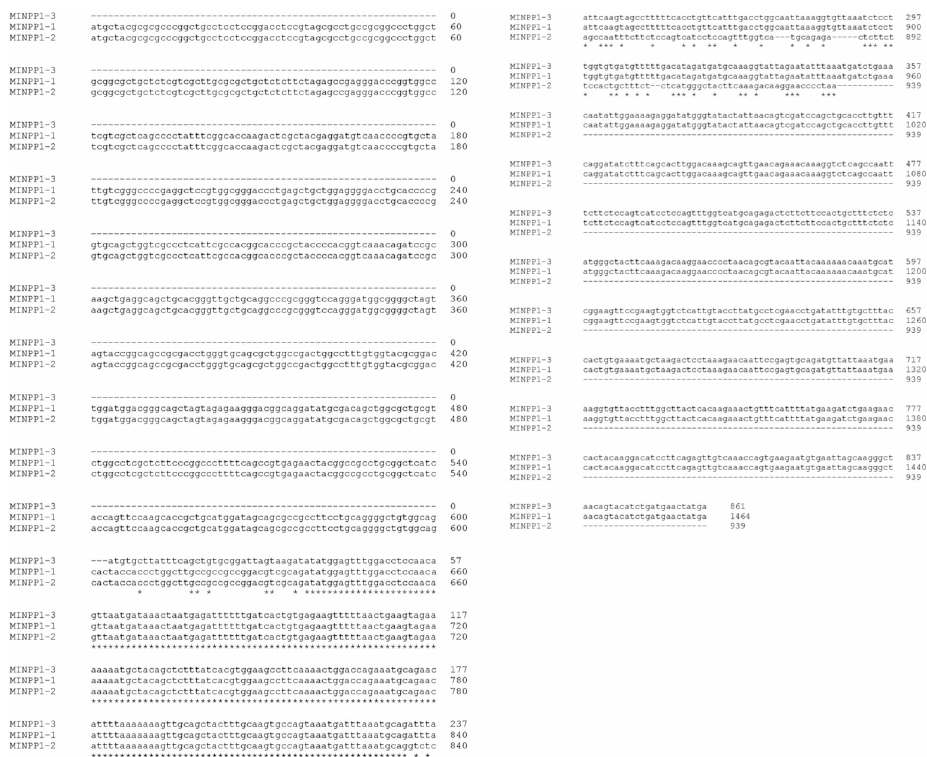
Fig 2. Nucleotide sequence alignment of multiple variants of hminpp1 : Three variants of the hminpp1 gene are identified. These variants are formed by alternative splicing of the gene. Homology modeling of the full-length sequences of the three variants collected from the NCBI database were aligned to evaluate sequence similarity. hminpp1 variant1 (NM_004897.5) is the full-length gene (MINPP1-1). hminpp1 variant-2 (MINPP1-2) comprises similar 5’ sequence but lacks substantial 3’ sequence. hminpp1 variant-3 (MINPP1-3) lacks 5’ sequence but retains 3’